Question: Does the figure show an increasing or a decreasing trend?
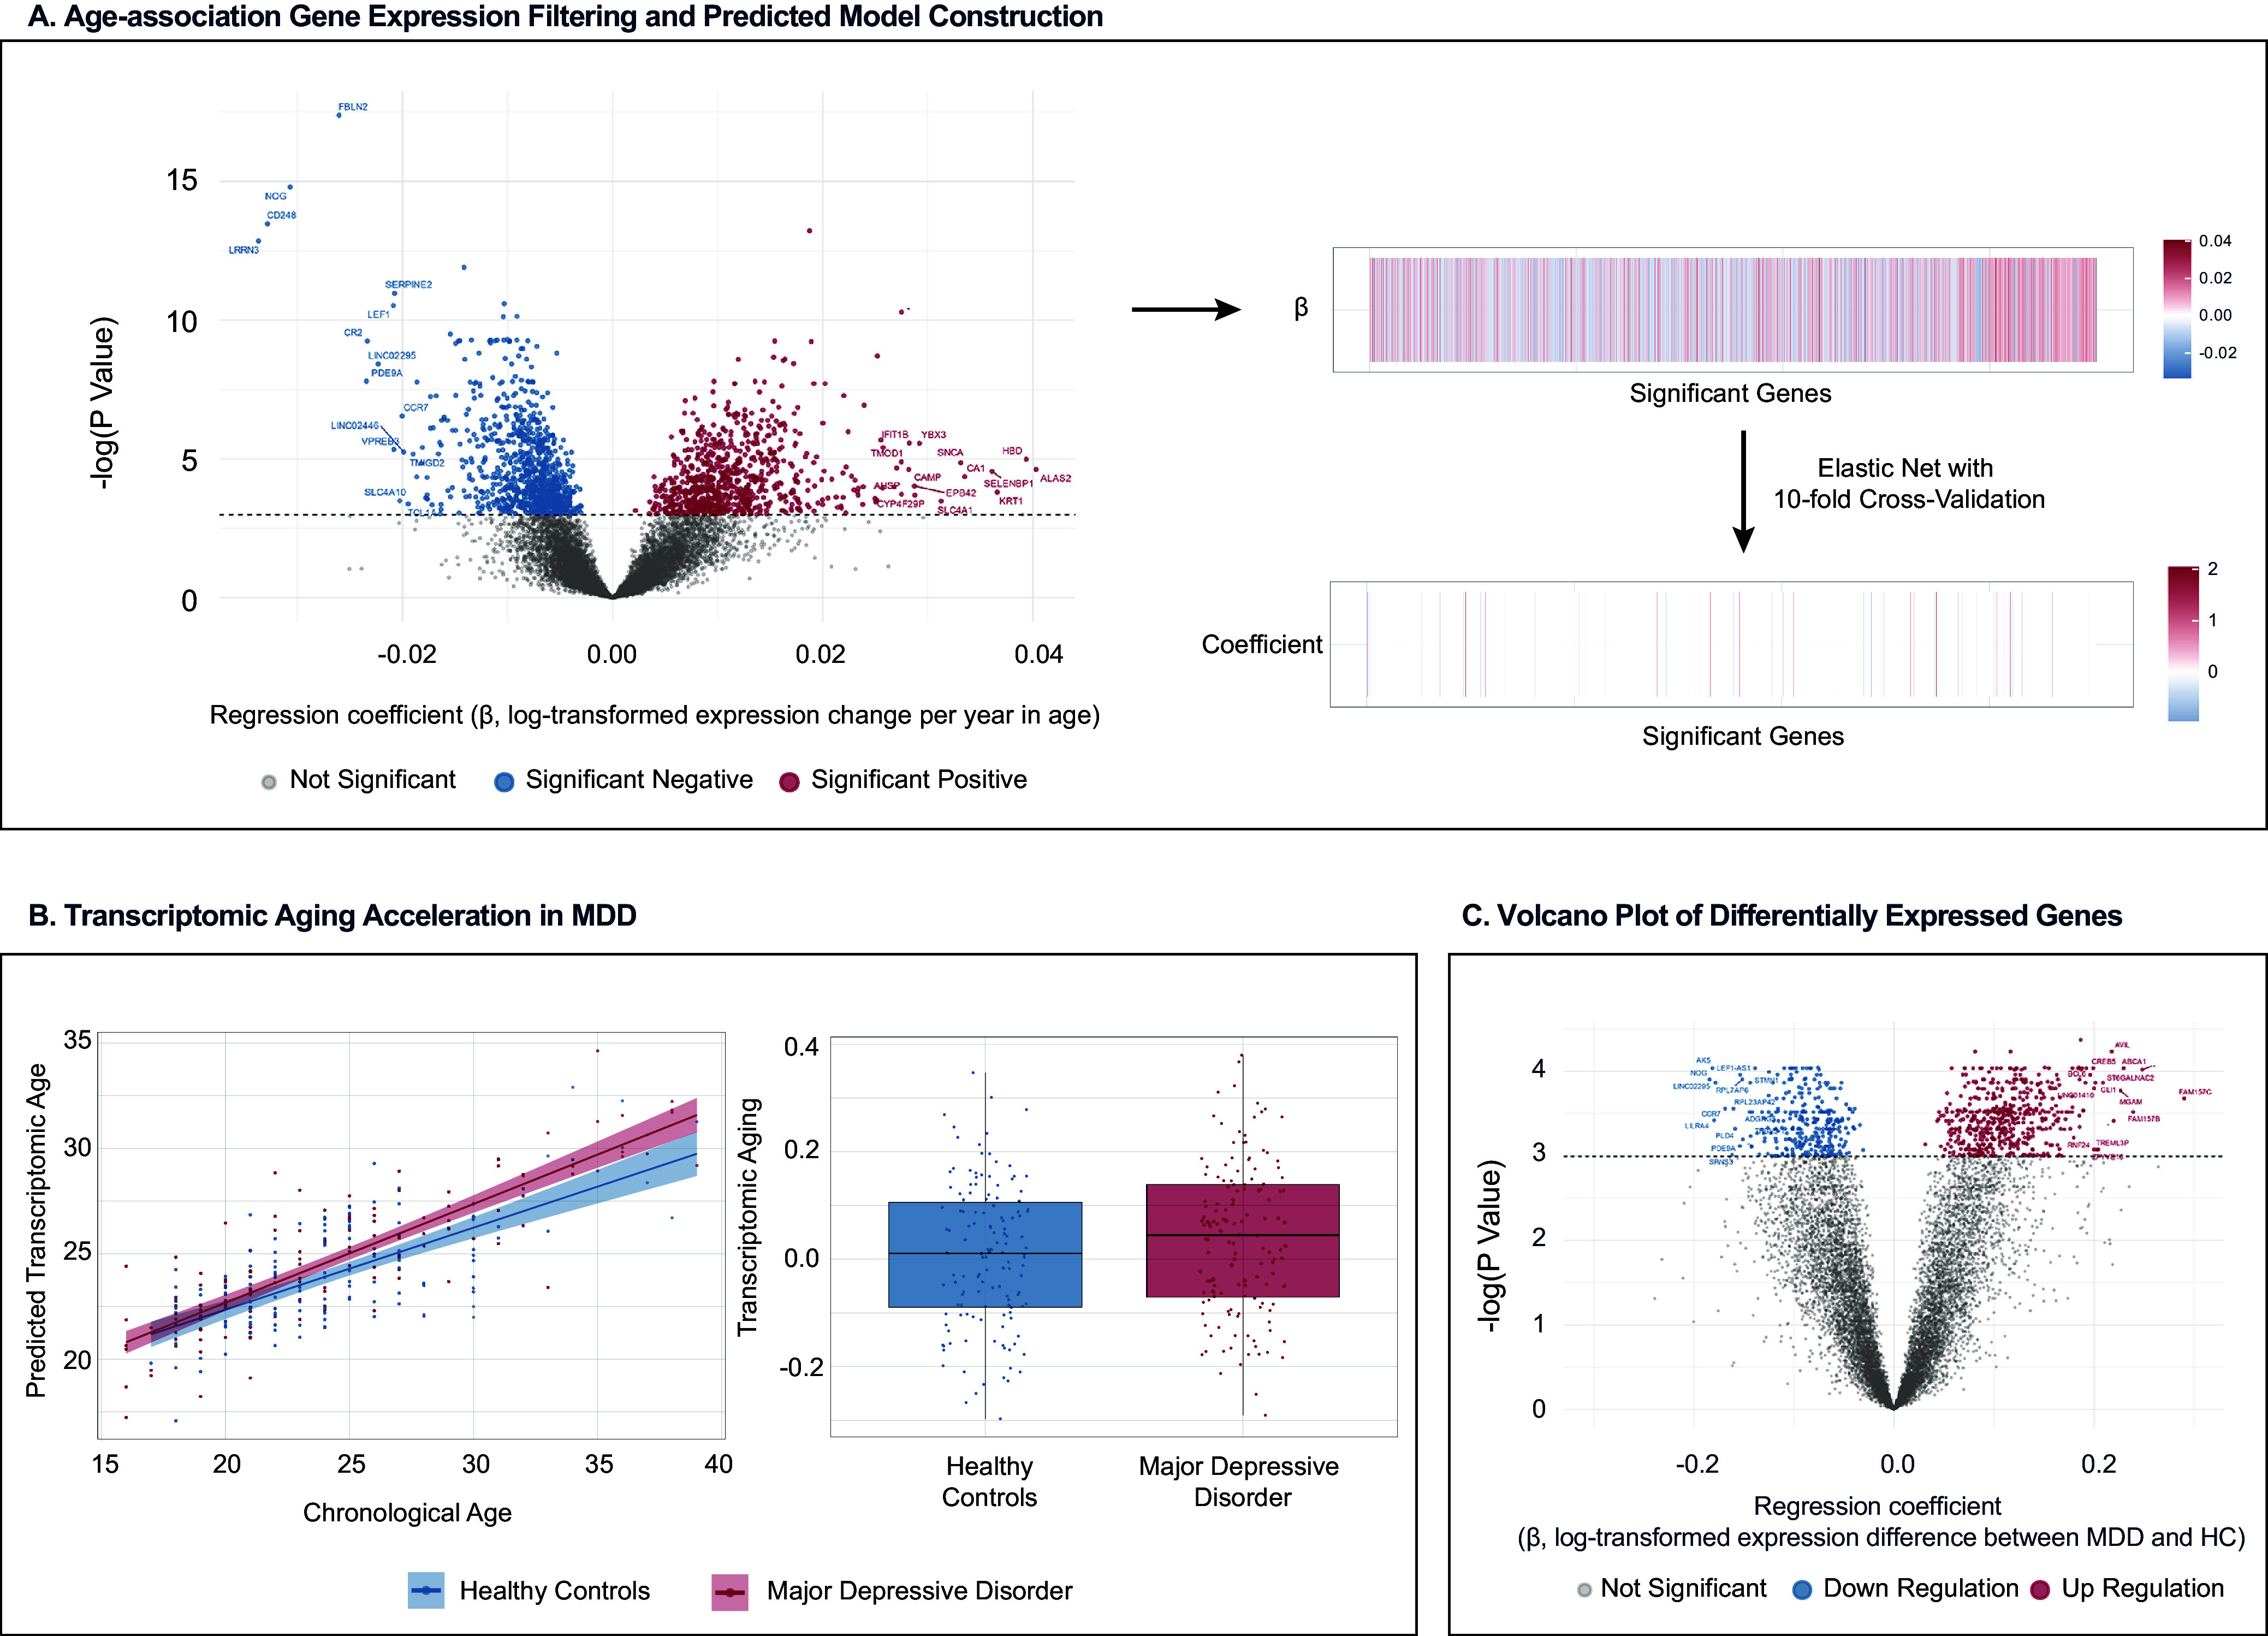
Answer: increasing